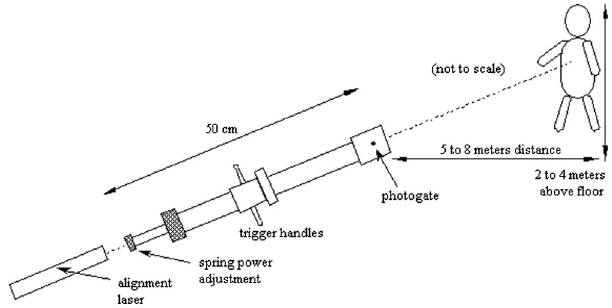
FIG. 2. Shoot the Monkey setup